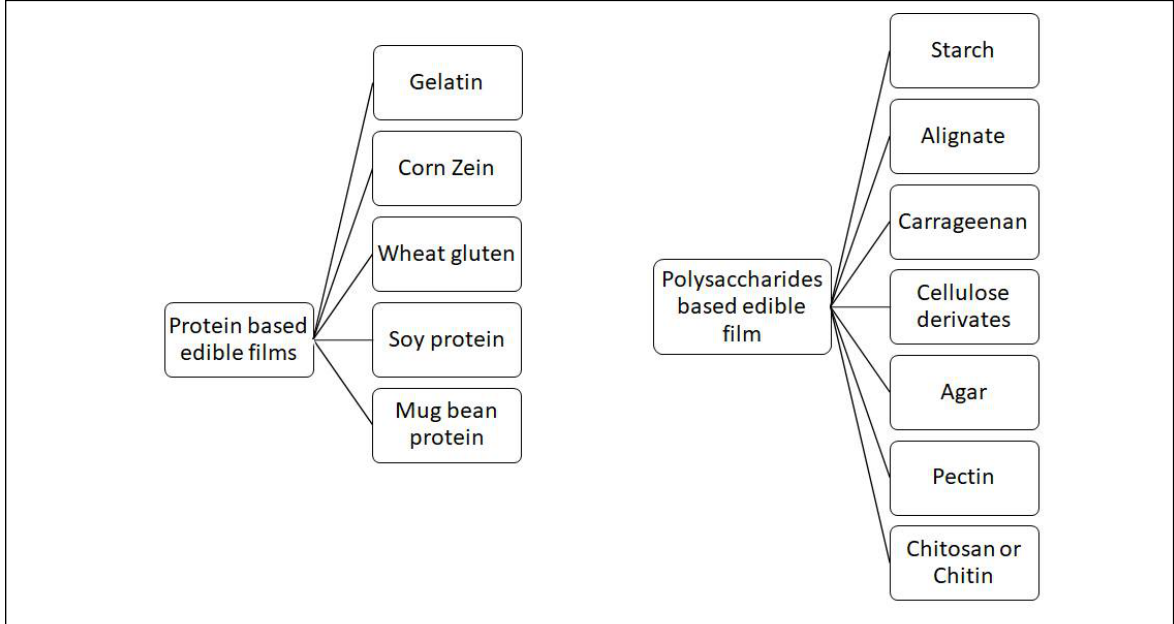
Figure 1: Classification of edible food packaging, Adapted from Mohan et al .,